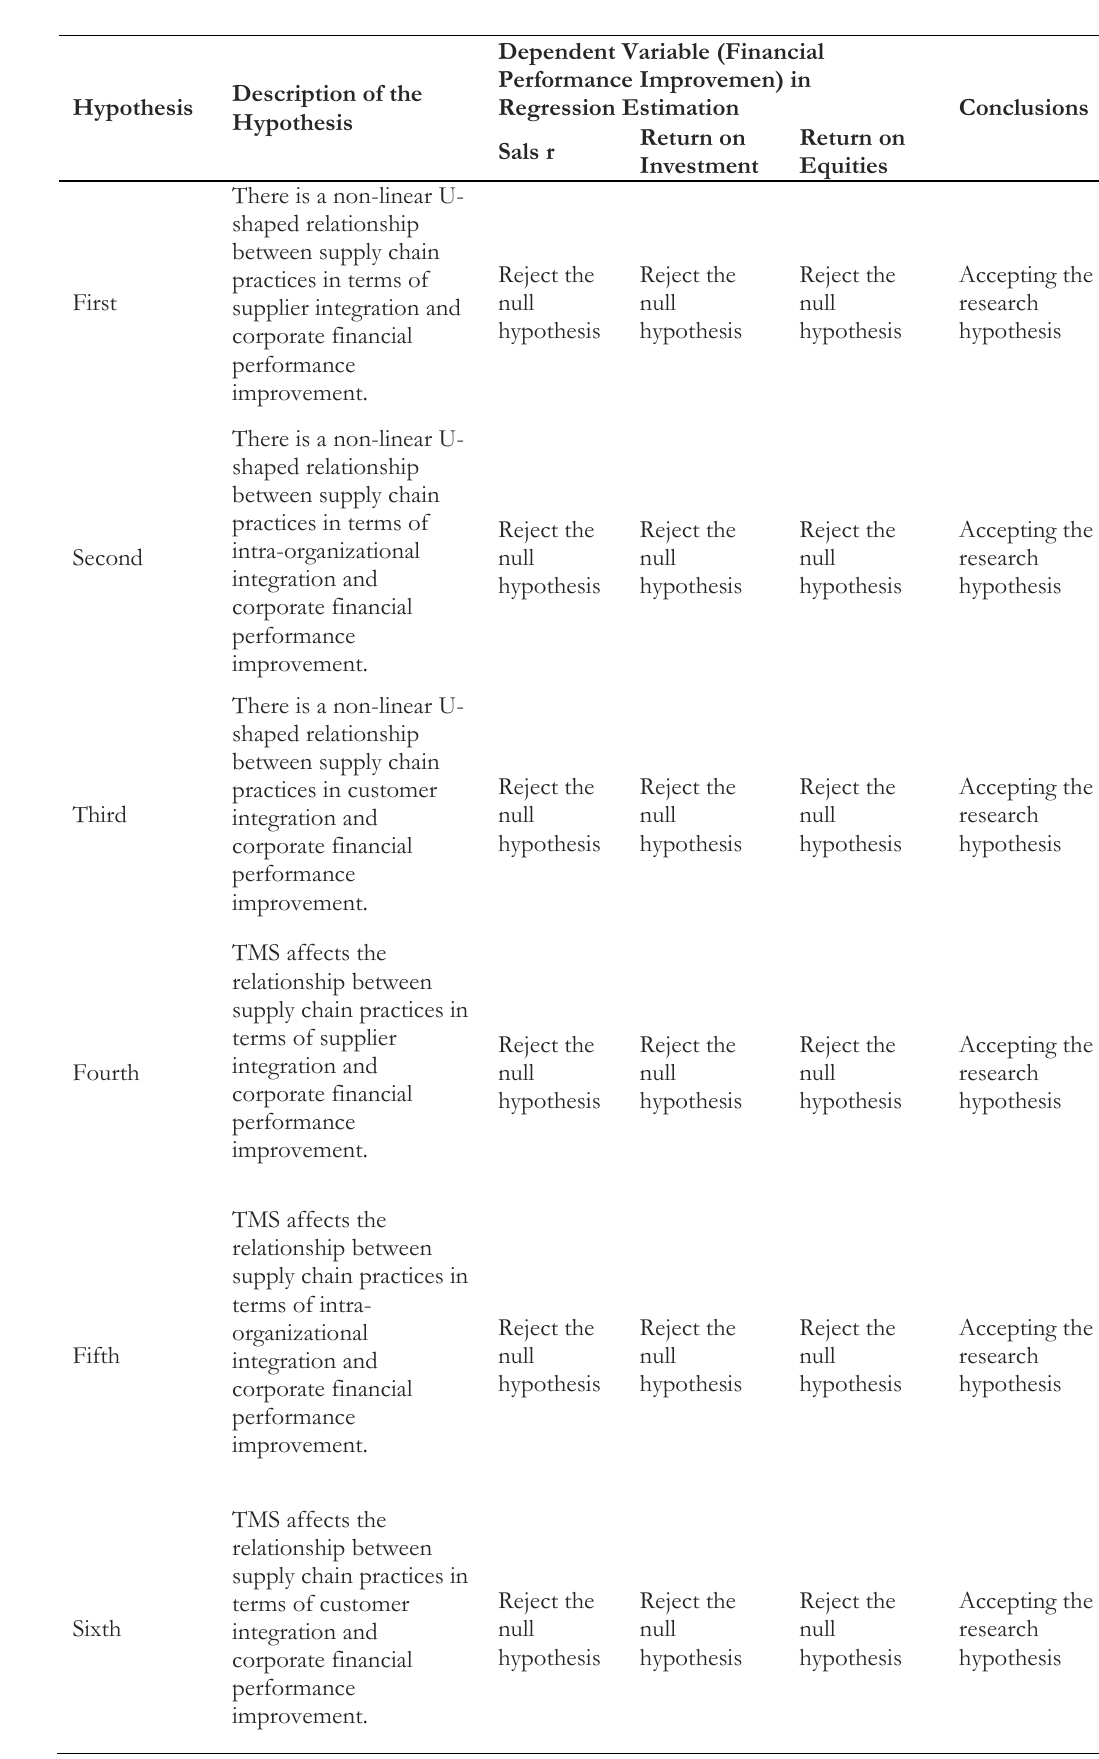
Table 4. Hypothesis test